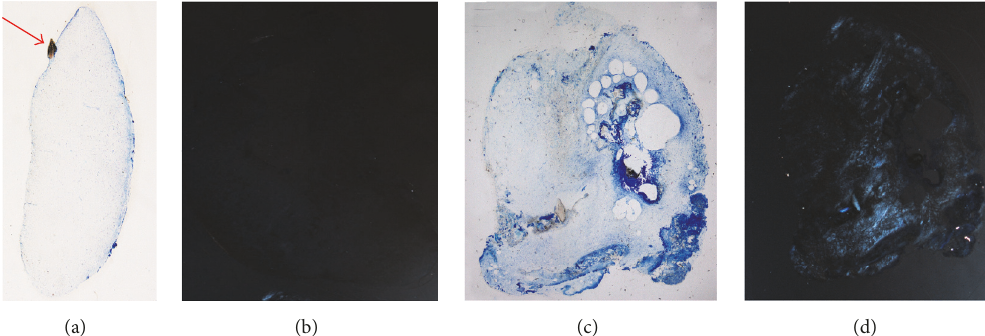
Figure 6: The ground sections of the two “ghost” teeth C (a-b) and D (c-d) under light microscope (a, c) and polarized microscope (b, d). The sections were stained with Toluidine Blue and Pyronin Y. Polarization highlighted a limited area containing mineralized tissue. The papilla in (b) did not present areas of calcified tissue, thus resulting as not birefringent.